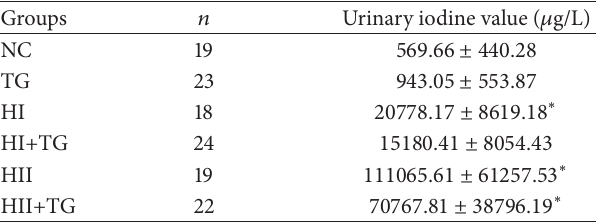
Table 1: Urinary iodine values in test rats (mean ±